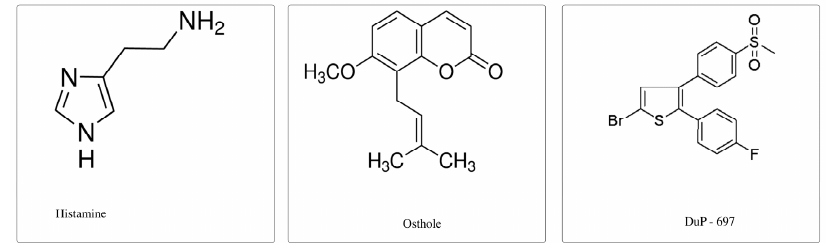
Figure 7. Chemical structures of histamine, osthole, and